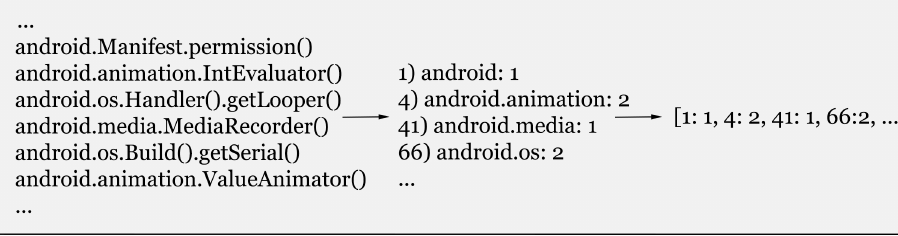
Figure 4. Example of feature mapping for the creation of the feature